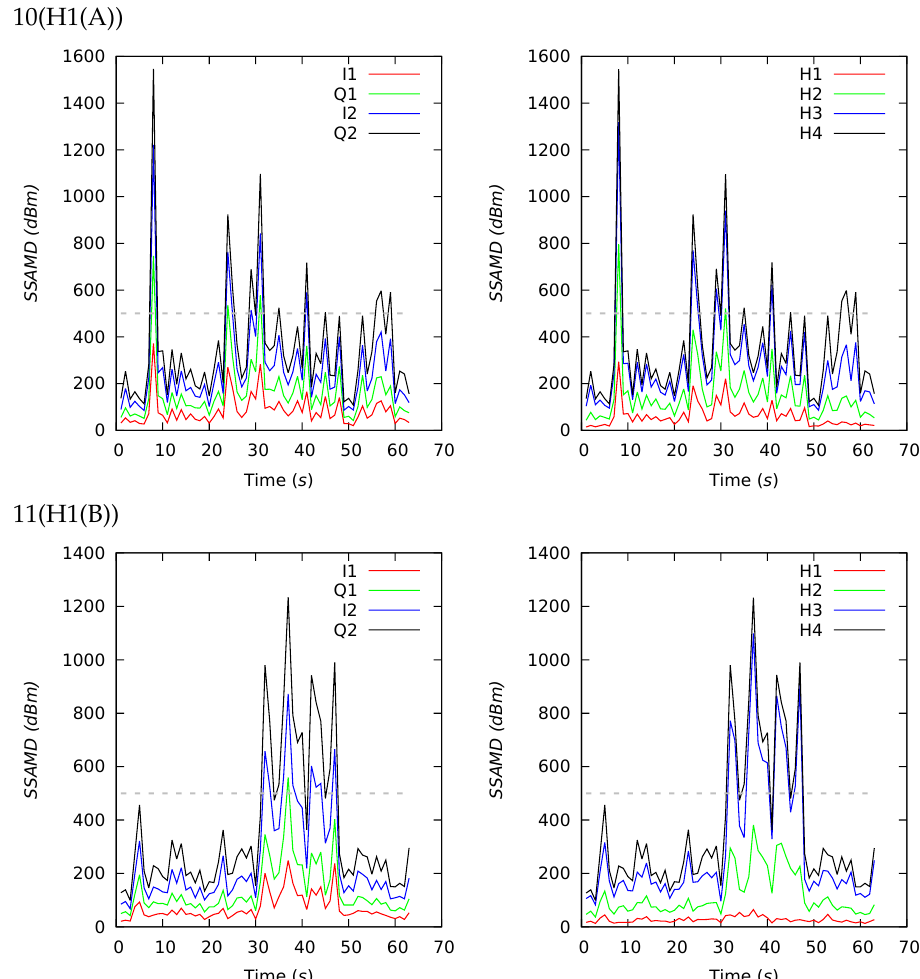
Figure A11. Experiment II, Sialis lutaria through the diffuser (10–11).